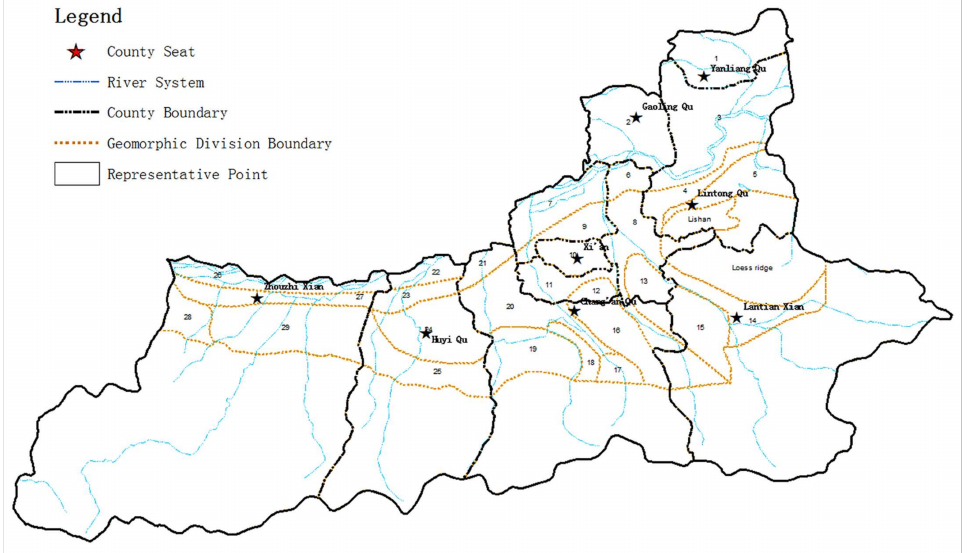
Figure 3. The distribution of representative points of groundwater overload assessment zones in the plain area of Xi’an